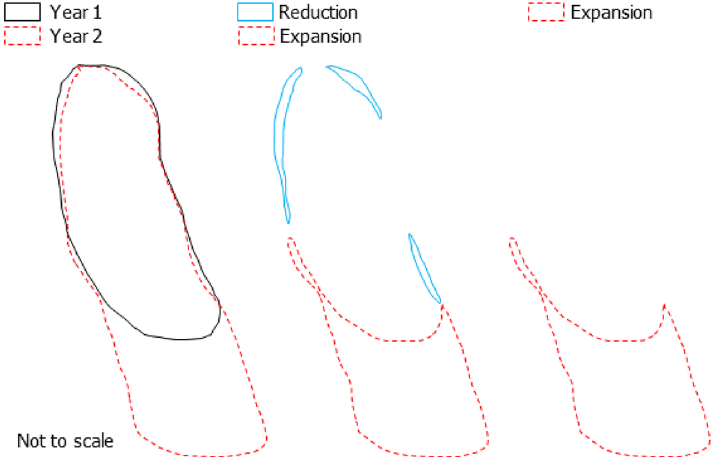
Figure 15. Example of landslide polygon subtraction. The first panel shows the boundaries of the landslides in Year 1 and Year 2, second panel shows the expansion and reduction part of the landslide after subtraction, and the third panel shows the expanded part after removal of the reduction